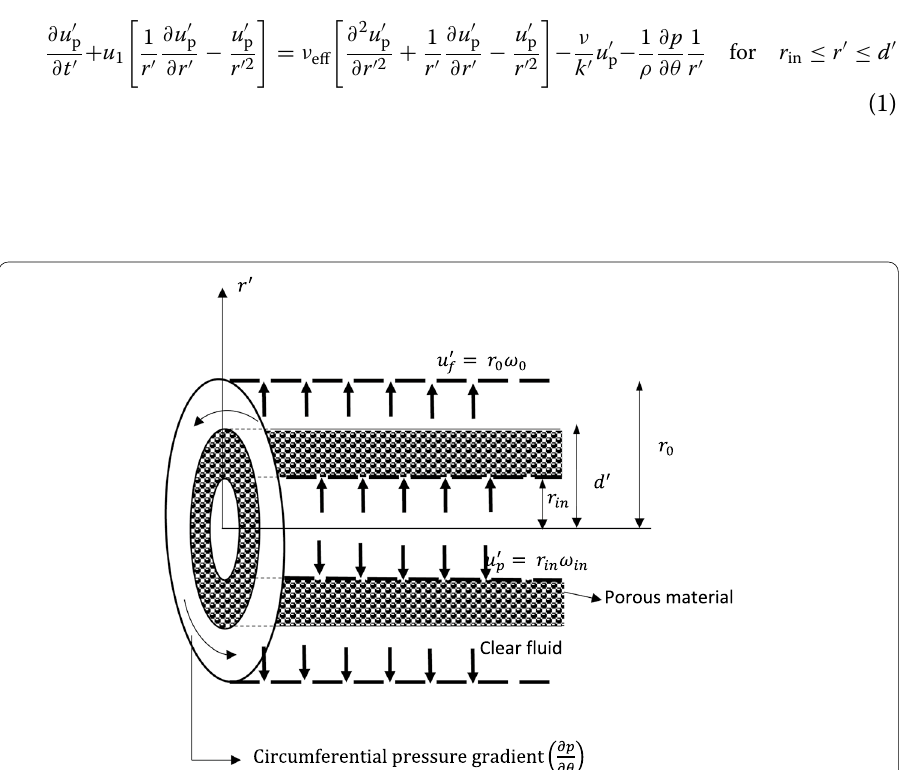
Fig. 1 Flow configuration and coordinate